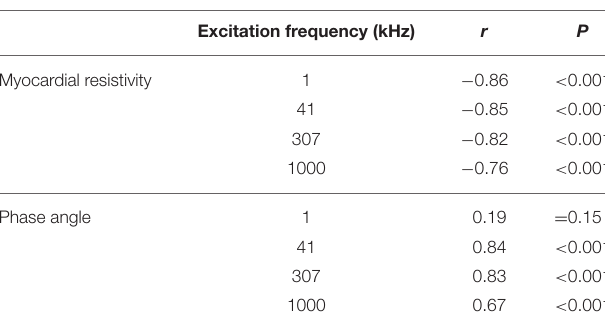
TABLE 1 | Correlation coefficients ( r ) between electrical impedance and percentage of infarct fibrosis in 59 tissue samples from six